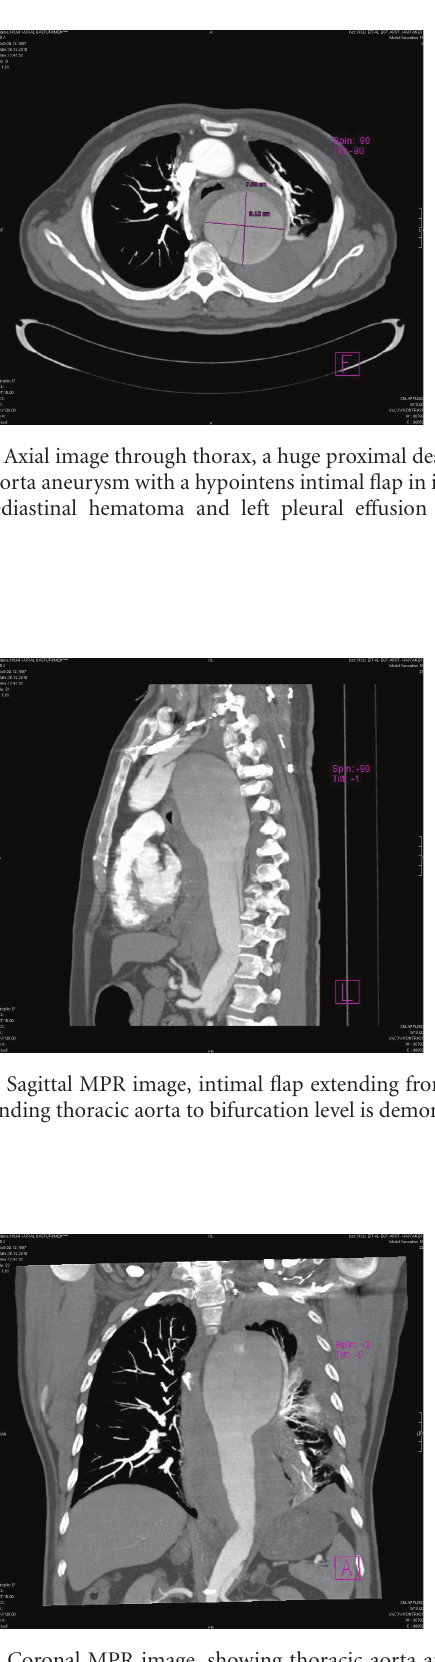
Figure 3: Coronal MPR image, showing thoracic aorta aneurysm and intimal